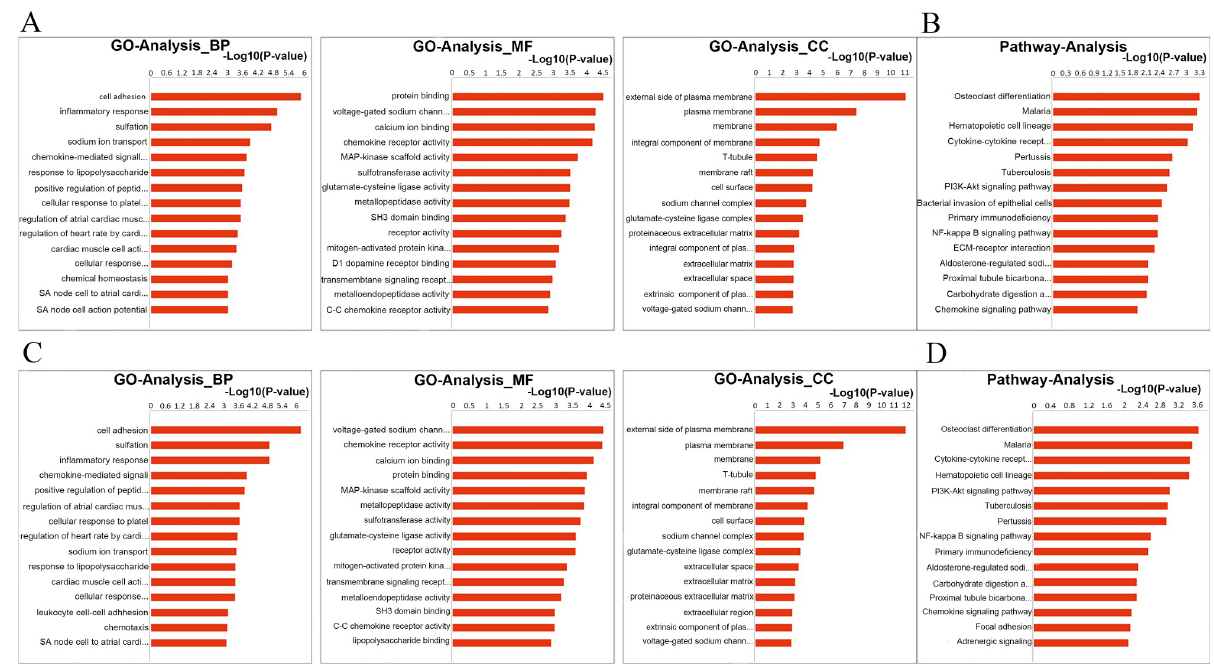
Fig 8. GO and KEGG analysis involving DE-mRNAs in the lncRNA/circRNA-miRNA-mRNA competing endogenous RNA network. (A) The top 30 GO terms of DE-mRNAs in the lncRNA-miRNA-mRNA competing endogenous RNA network, including MF, CC and BP classification. The horizontal axis is the enrichment value of functional degree, and the vertical axis is the entry name corresponding to GO in the Gene Ontology database. (B) KEGG analysis of DE-mRNAs in the lncRNA-miRNA-mRNA competing endogenous RNA network. (C) The top 30 GO terms of DE- mRNAs in the circRNA-miRNA-mRNA competing endogenous RNA network, including MF, CC and BP classification. The horizontal axis is the enrichment value of functional degree, and the vertical axis is the entry name corresponding to GO in the Gene Ontology database. (D) KEGG analysis ofDE-mRNAs in the circRNA-miRNA-mRNA competing endogenous RNA network. GO, Gene Ontology; KEGG, Kyoto Encyclopedia of Genes and Genomes pathway; MF, molecular function; CC, cellular component; BP, biological process.